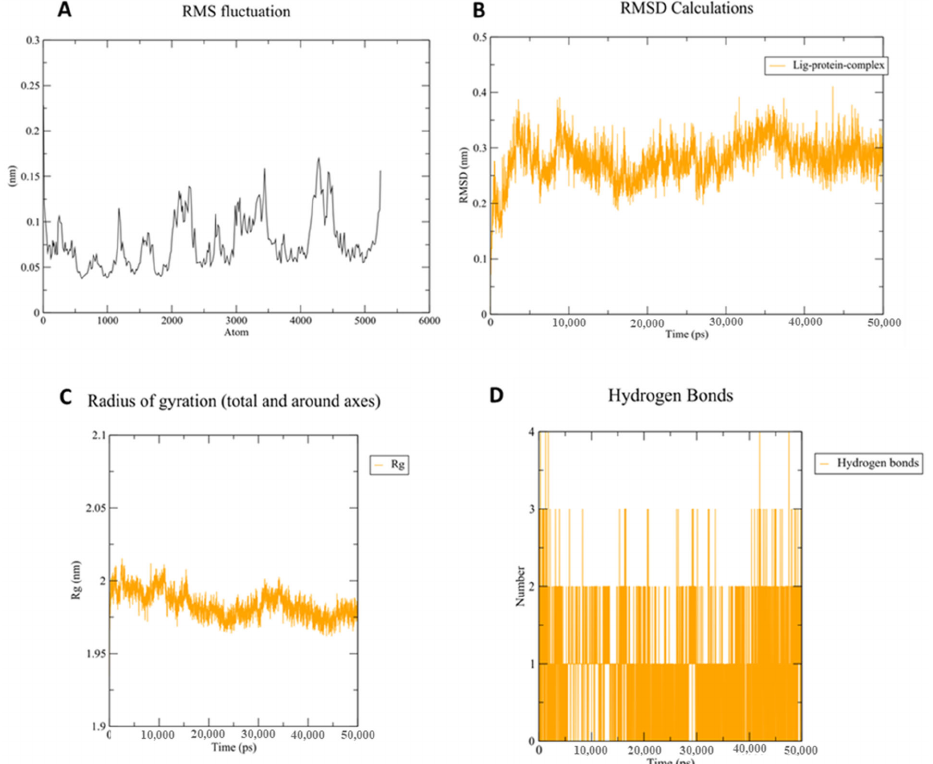
Figure 11. Molecular dynamic (MD) analysis of ligand 11b into PDE5 protein (PDB ID: 3HC8). ( A ) RMSF values of PDE5 residues during 50 ns MD simulations; ( B ) RMSD of ligand ( 11b ) and protein (PDE5) backbone obtained from 50 ns MD simulation; ( C ) radius of gyration (Rg) showing no drastic folding of PDE5 during the 50 ns MD simulation; ( D ) assessment of the number of H ‐ bonds formed between the ligand ( 11b ) and the target (PDE5) during 50 ns MD simulations.